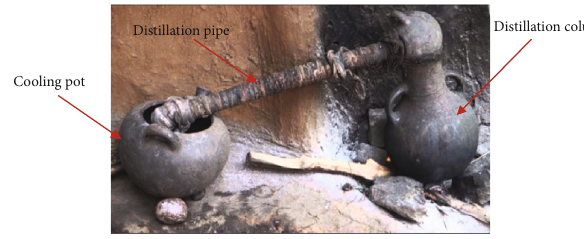
Figure 2: Traditional “ Areke ”